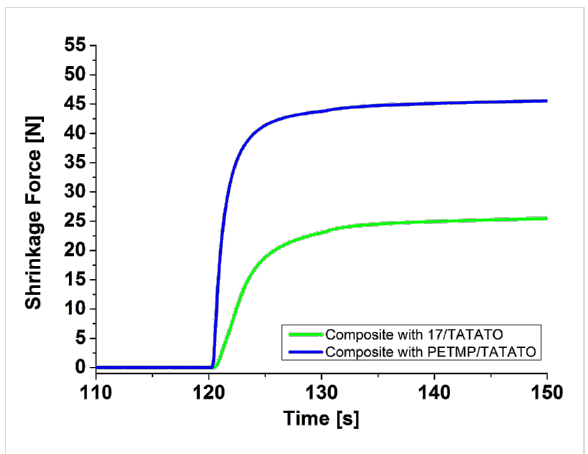
Figure 3: Development of the shrinkage force as function of time of dental composites containing 39.8 wt % organic matrix based stoichio- metric amounts of TATATO and the thiol component (PETMP (blue line) or 17 (green line)), 59.98 wt % inorganic filler, 0.20 wt % initiator (K69) and 0.02 wt % Q1301. The exposure to light was initiated after 120